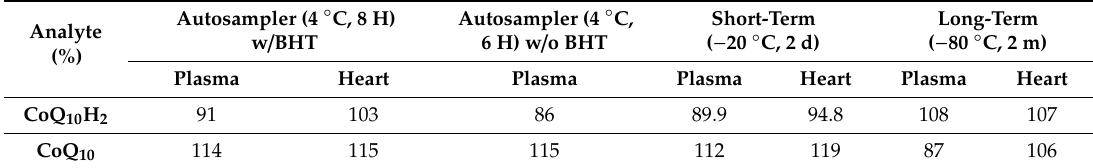
Table 2. Stability results of CoQ 10 H 2 and CoQ 10 in extracted canine plasma and heart tissue at 4 ◦ C and − 20 ◦ C and un-extracted canine plasma and heart tissue at − 80 ◦ C ( n = 3). Extracted canine plasma was investigated with and without the addition of the antioxidant BHT at 4 ◦